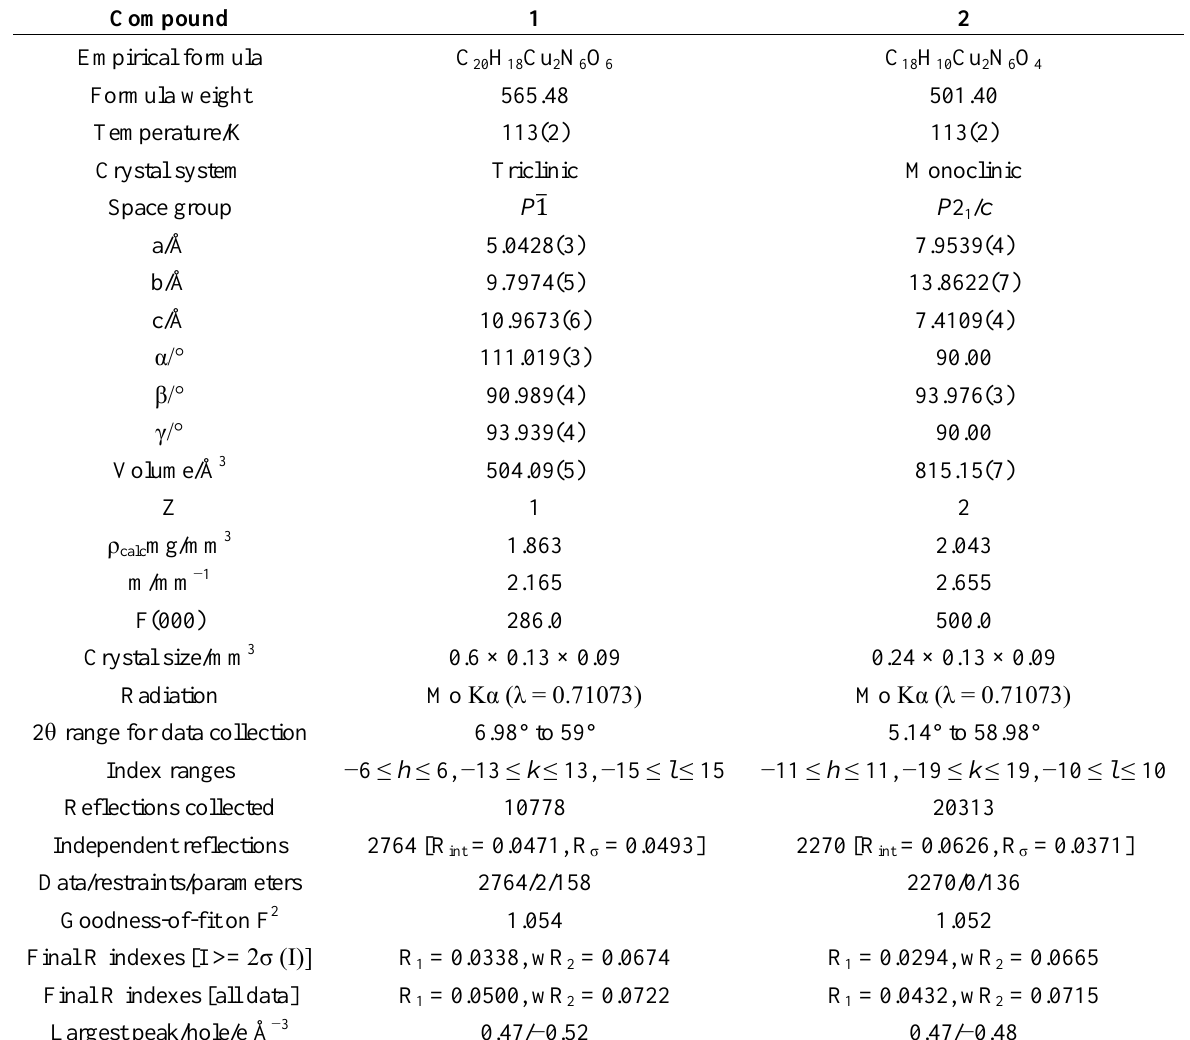
Table 1. Crystallographic and refinement parameters for compounds 1 and 2